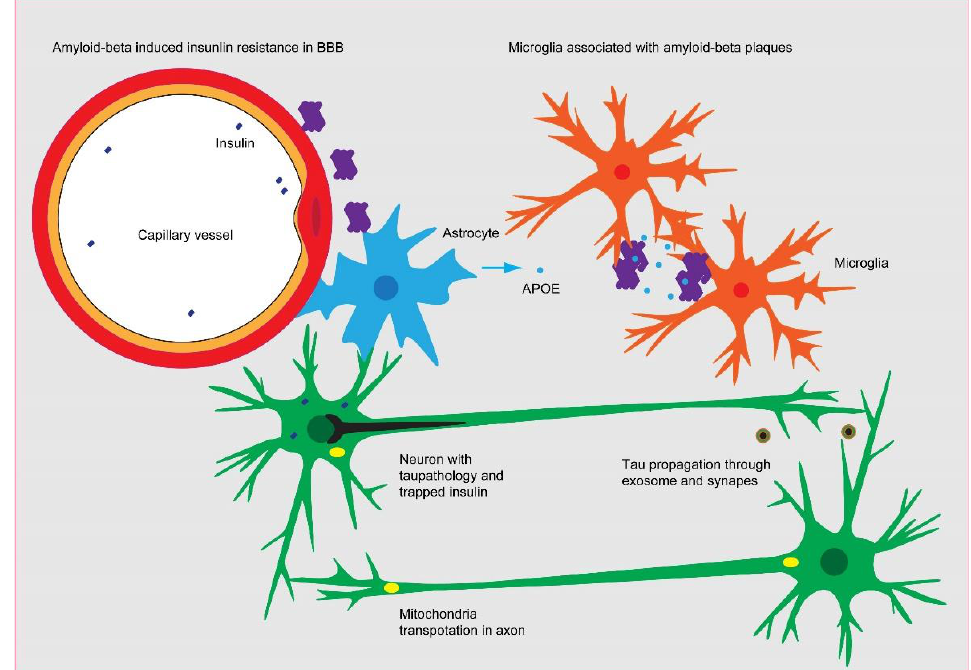
Figure 1. The probable linkage between A β , insulin signaling, tau pathology, and microglia activation in AD. The constant production of A β needs to be eliminated by microglia through endocytosis and/or by the drainage of micro-vessels, as evidenced by the association of A β plaques with microglia and micro-vessels in AD brain. However, the overloading of A β leads to the impairment of insulin sensing in the brain – blood barrier and parenchyma, which triggers the phosphorylation of tau and subsequently perturbs mitochondria and insulin secretion. The tau pathology could be propagated via the synapse and exosome in a microglia-dependent manner, eventually leading to neural atrophy.